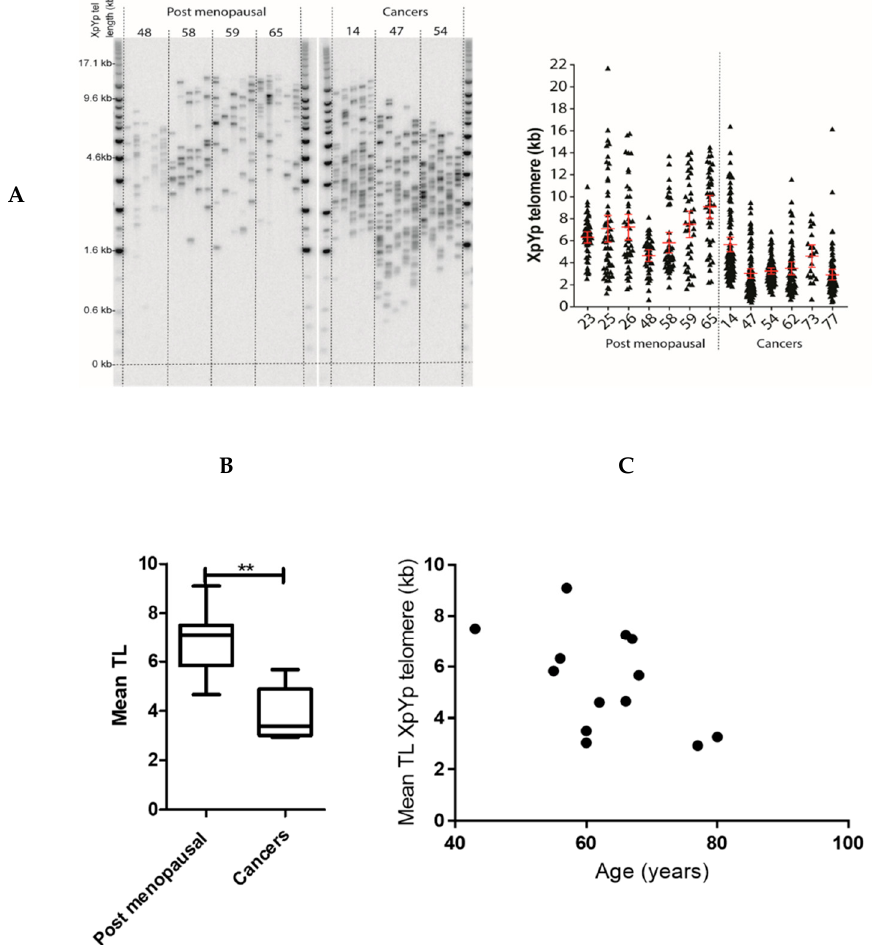
Figure 4. Single telomere length analysis at XpYp telomeres, telomere length distributions in healthy post-menopausal endometrial and endometrial cancer tissue. Representative STELA gel image, together with the distribution of telomere lengths represented as a scatter plot ( A ). Mean telomere lengths in healthy postmenopausal endometrium compared to endometrial cancers. Telomere lengths are significantly shorter in endometrial cancers compared to postmenopausal endometrium (** p = 0.002, Mann–Whitney-U test) ( B ). Telomere length correlated with age of the patients, demonstrating no significant association with age and mean telomere lengths (Spearman correlation, r = − 0.49, p = 0.09) ( C ).